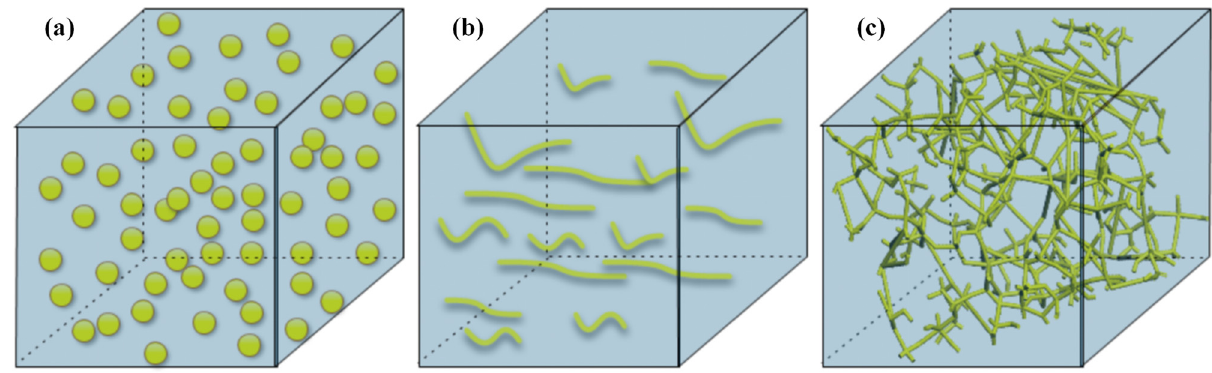
Figure 1: Schematic diagram of the internal structure of composite materials with di ff erent reinforcement methods: ( a ) particle reinforce - ment; ( b ) fi ber reinforcement; and ( c ) three - dimensional network